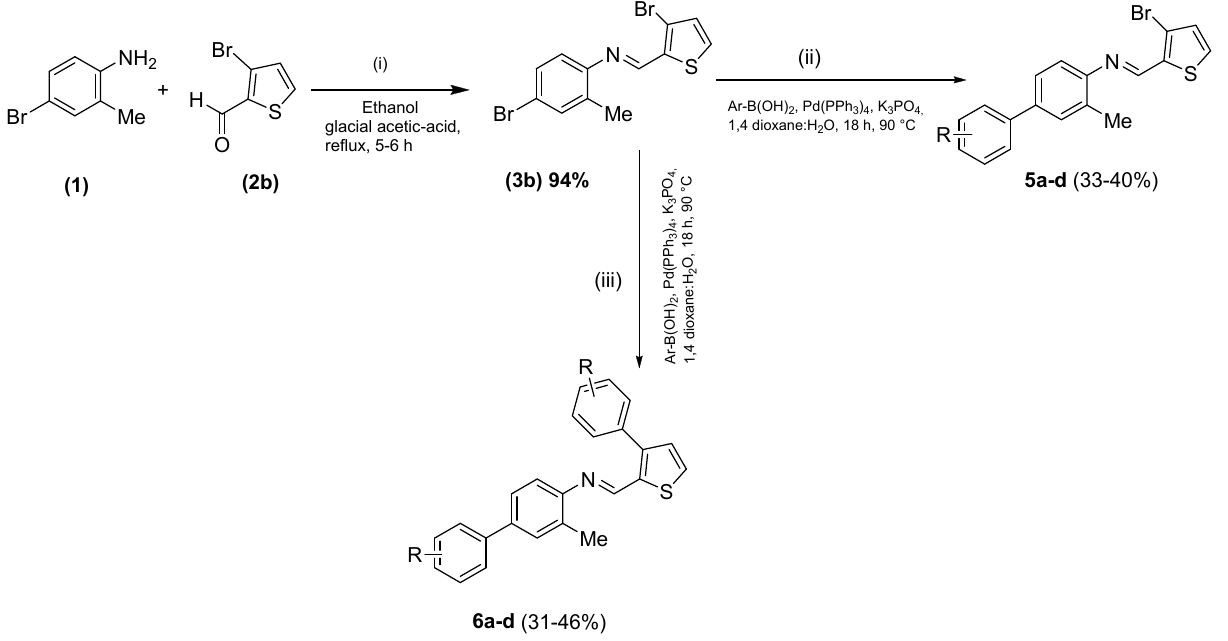
Scheme 2. Synthesis of ( E )-4-bromo- N -((3-bromothiophen-2-yl)methylene)-2-methylaniline ( 3b ) and Suzuki-coupling of 3b with aryl boronic-acids. Reagents and conditions : (i) 1 (0.307 g, 1.612 mmol), 2b (0.307 g, 1.612 mmol), ethanol (10 mL), glacial acetic acid (5–6 drops) (ii) 3b (0.150 g, 0.417 mmol), Pd(PPh 3 ) 4 (0.0241 g, 5-mol%), arylboronic acid (1 eq, 0.4178 mmol), K 3 PO 4 (0.195 g, 0.918 mmol) (iii) 3b (0.150 g, 0.417 mmol), Pd(PPh 3 ) 4 (0.0241 g, 5-mol%), arylboronic acid (2 eq, 0.4178 mmol), K 3 PO 4 (0.177 g, 0.835 mmol) Lack of reactivity was observed with ortho -substituted arylboronic acids due to steric factors which hinder the in mechanism during the transmetalation step [21,22], and as a